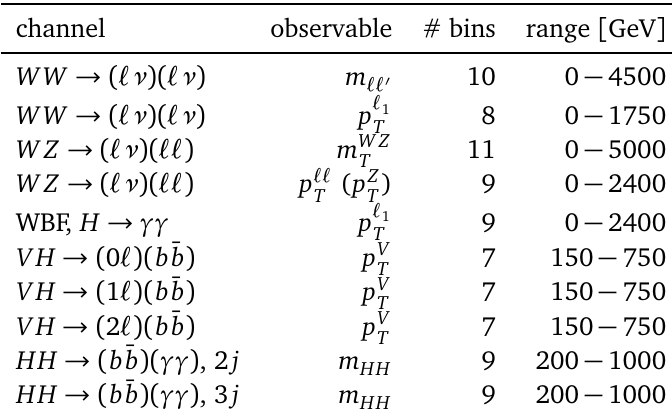
Table 2: Distributions included in the analysis. The number of bins includes an over- flow bin for all